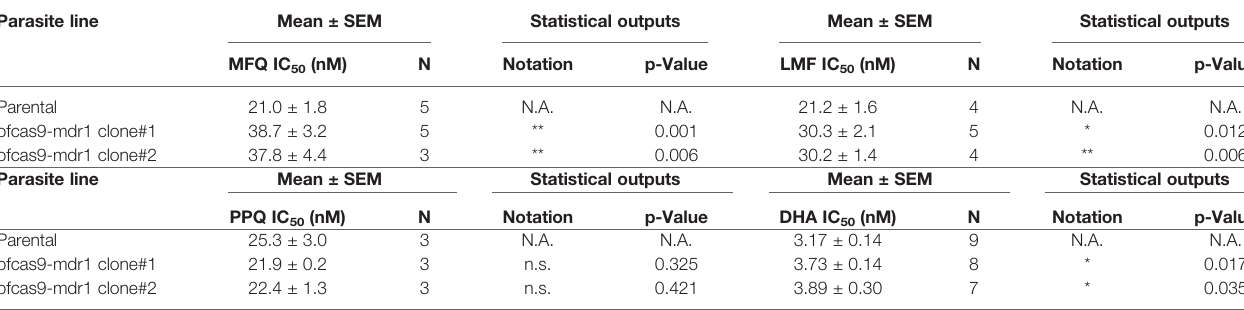
TABLE 1 | IC 50 values of me fl oquine, piperaquine, lumefantrine, and dihydroartemisinin with pfcas9-mdr1. Parasite line